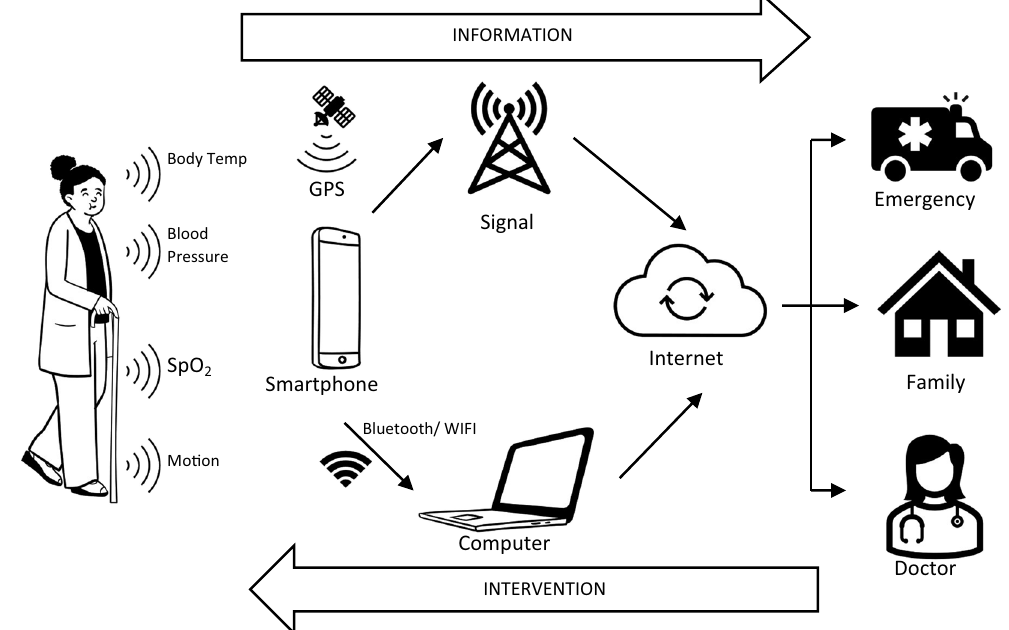
Figure 1: A basic structure of IoT - based healthcare